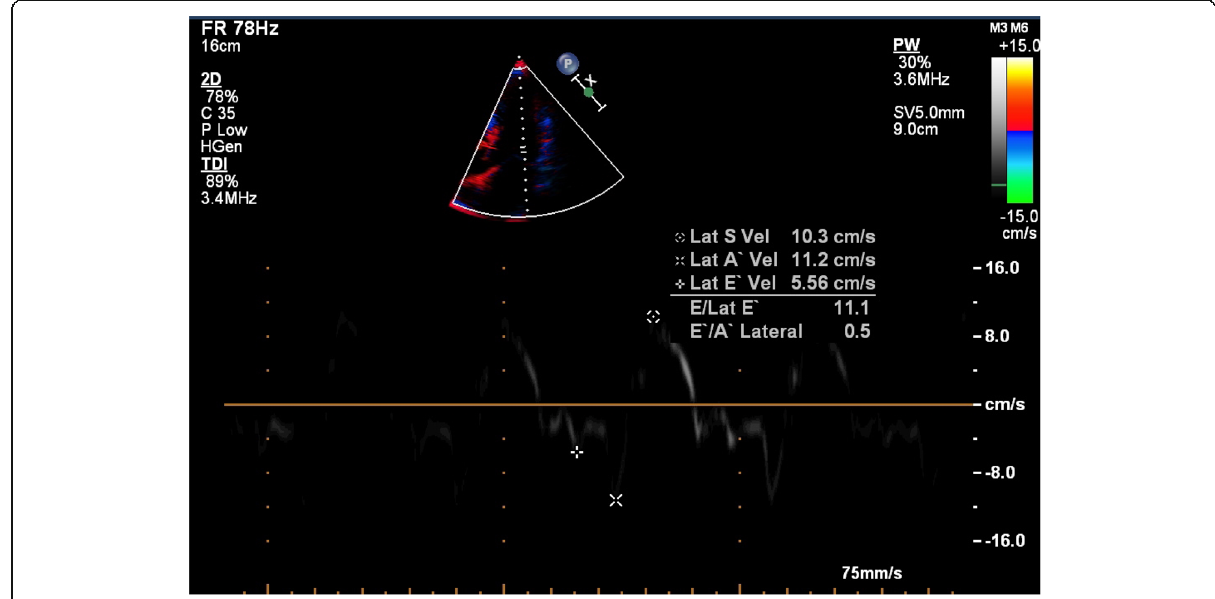
Fig. 4 Assessment of diastolic function by lateral mitral annulus tissue Doppler